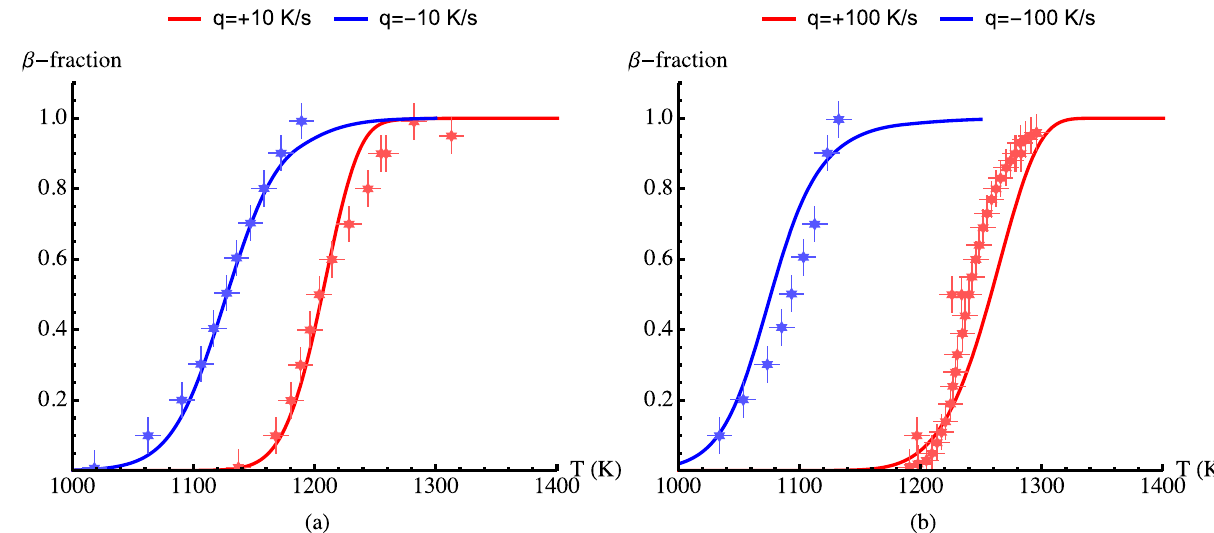
Figure 12. Volume fraction of β phase as a function of temperature calculated (lines) by using model B versus measured data (markers) for Zircaloy-4. The bars indicate -fraction and temperature, respectively. ( a ) q